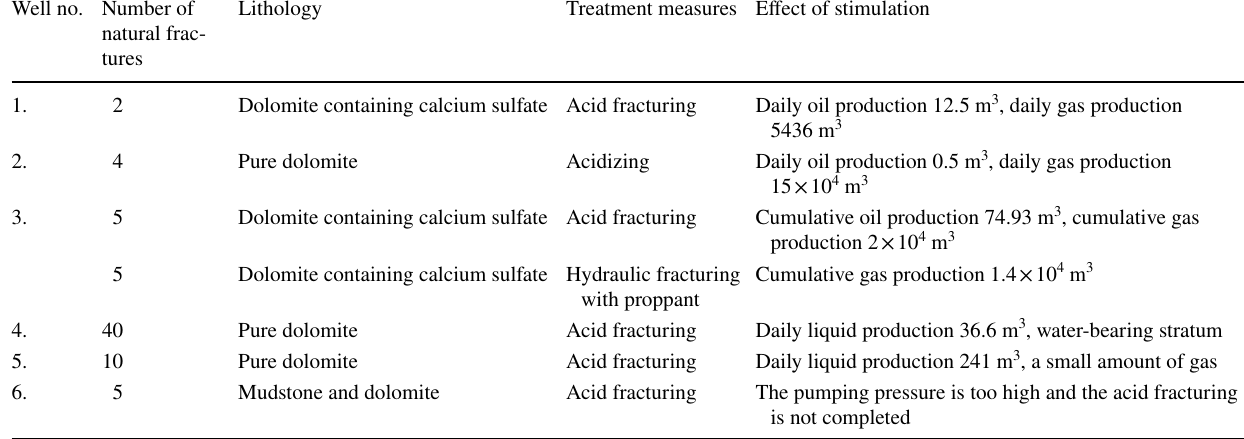
Table 1 Seven times treatment measures of 6 wells Well no. Number of natural